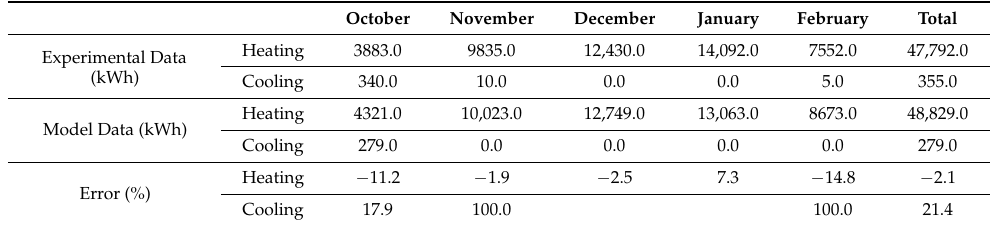
Table 6. Experimental Versus Model Data for Heating and Cooling Consumption from October to February. HVAC Performance with Surgical